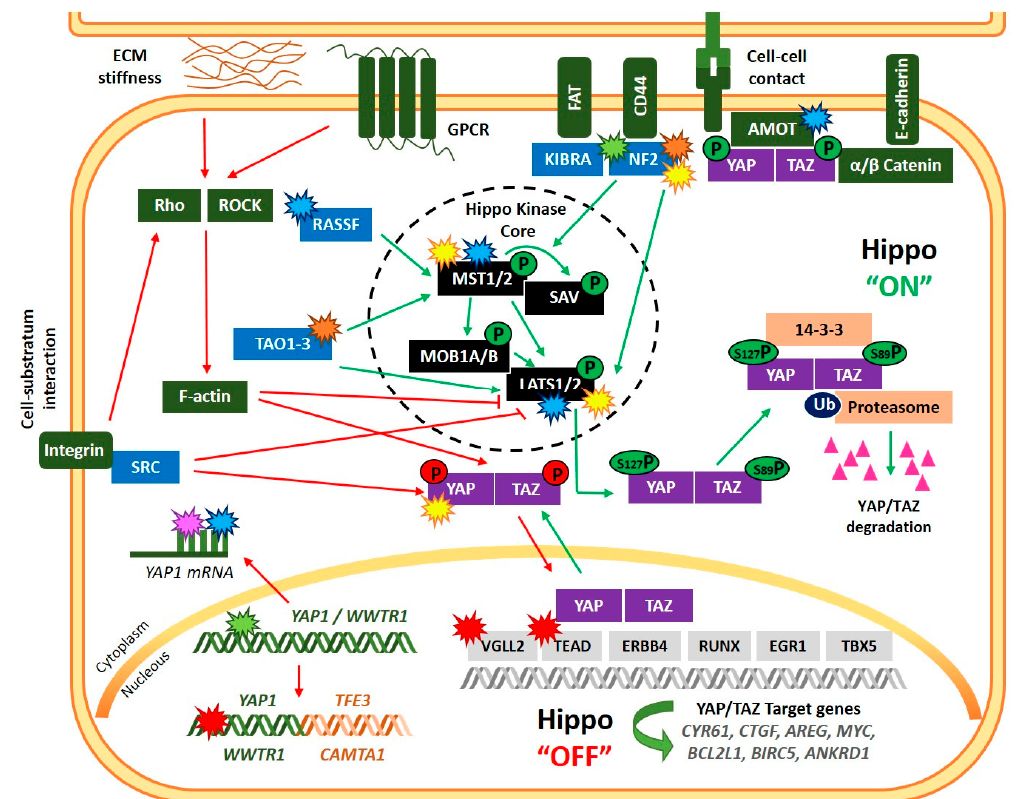
Figure 1. Regulation of the Hippo signaling pathway and main alterations of Hippo-pathway members reported in sarcomas. Green arrow lines and phosphates indicate induction of Hippo “ON” status, while red arrow lines and phosphates indicate “OFF” status. Alterations of the Hippo-pathway members are displayed with start symbols with colors denoting: transcriptional (green); post-transcriptional (pink); post-translational (yellow); epigenetic (blue), mutation/copy number alteration (orange) and chromosomal rearrangement (red) aberrations. An example of chromosomal rearrangement involving YAP1 and WWTR1 is showed in the figure ( YAP1::TFE3 and WWTR1::CAMTA1 ). Table 1. Deregulation mechanisms of Hippo pathway in sarcomas .